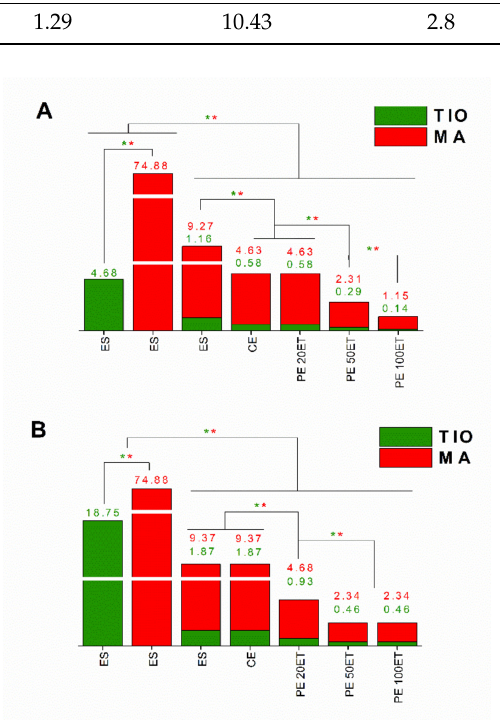
Figure 4. Minimum inhibitory concentration (MIC 90 ) of ES-TIO, ES-MA, ES-TIO-MA, CE-TIO-MA, PE 20ET-TIO-MA, PE 50ET-TIO-MA, and PE 100ET-TIO-MA in µ g / mL on T. rubrum ( A ) and C. albicans ( B ). Six independent experiments with three technical replicates were performed. The green ( * ) and red ( * ) asterisks represent a significance value of p < 0.01 for the MIC 90 ,